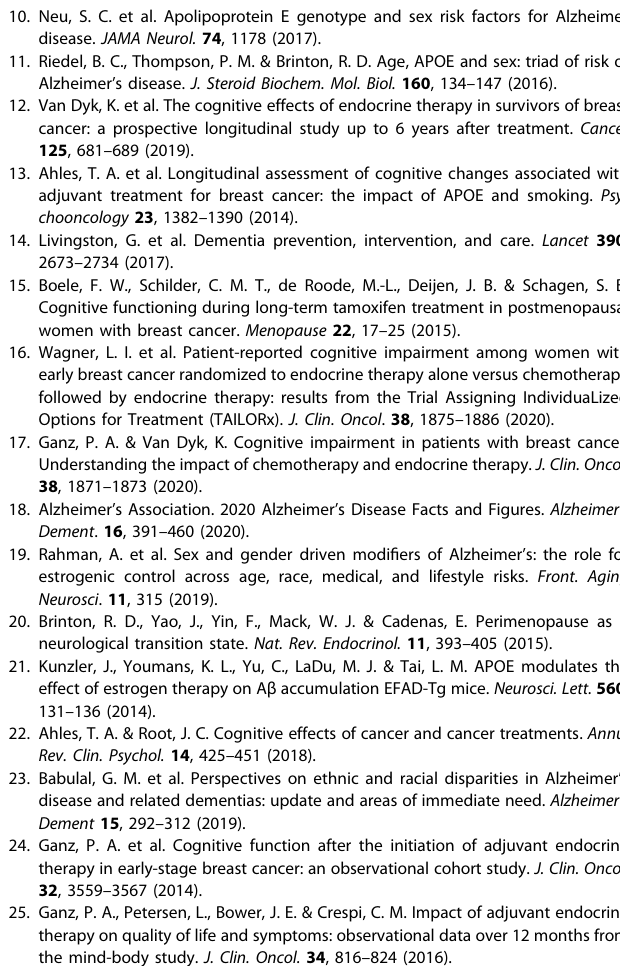
Fig. 1 Cognitive domain scores in the endocrine therapy group by APOE ε 4 status at 3 – 6 years post baseline. Models adjusted for age, IQ, chemotherapy, and race. Error bars represent ±1